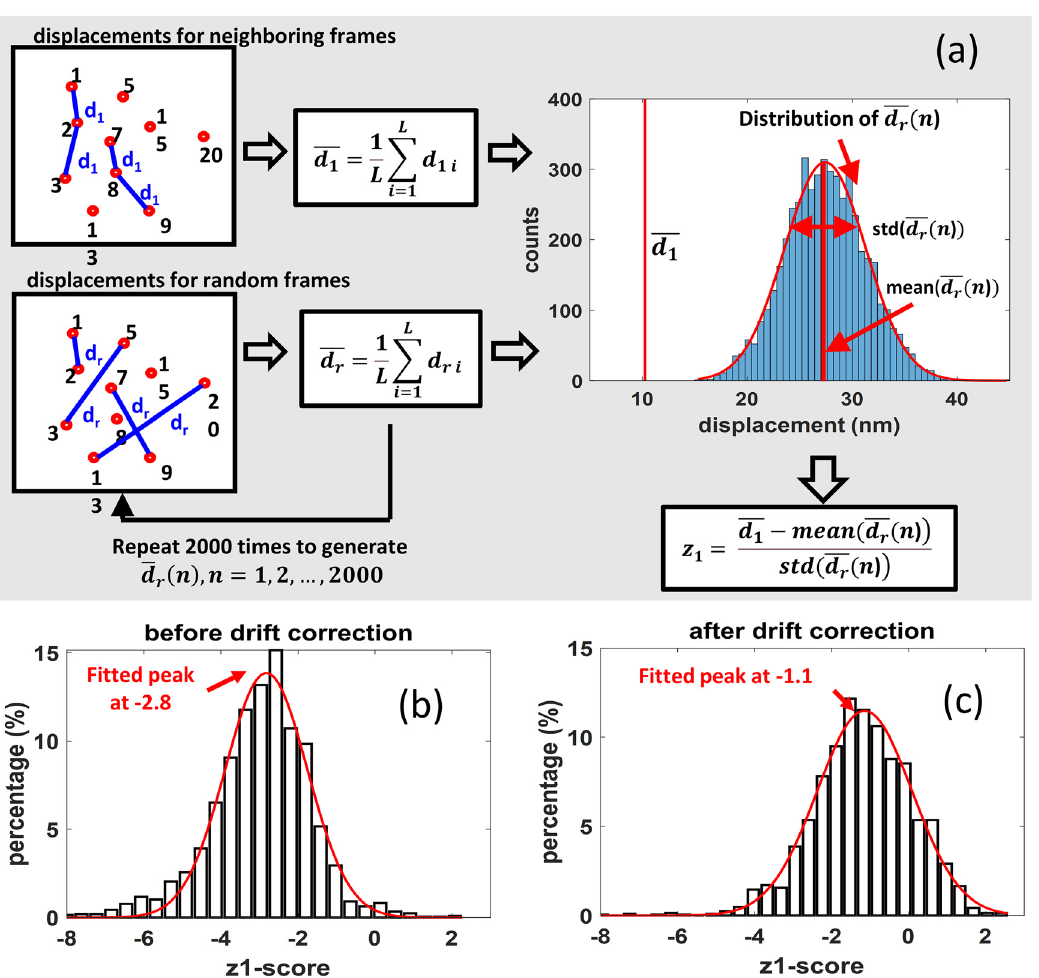
Figure 2: Calculation of neighboring z-scores of immobilized biomolecules shows the existence of biomolecule stochastic motion after drift